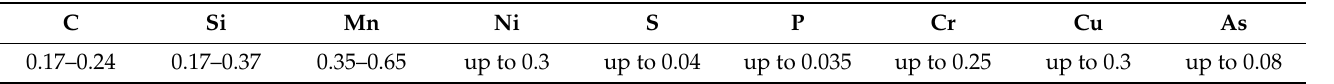
Table 1. Chemical composition of low-carbon steel substrate (at.